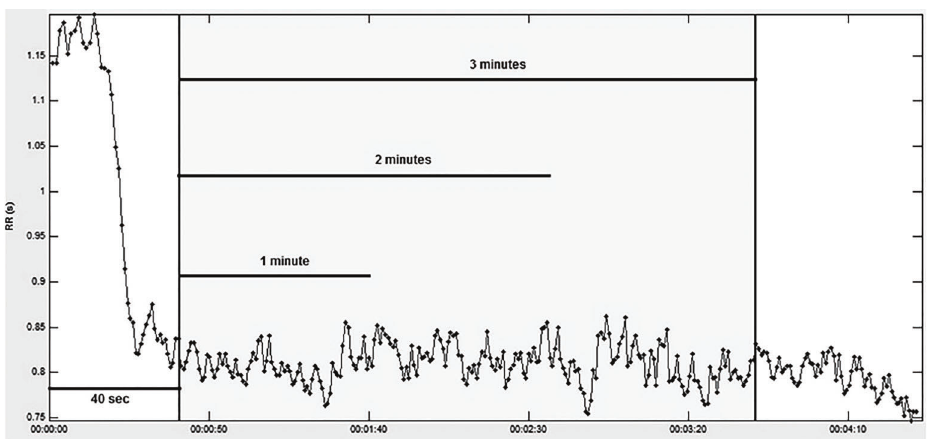
Figure 1. Illustration of a heart rate variability signal acquired during dynamic resistance exercise at an intensity of 30% 1-repetition maximum test and its subdivision in 1-, 2-, and 3-min portions. RR: time between R waves.